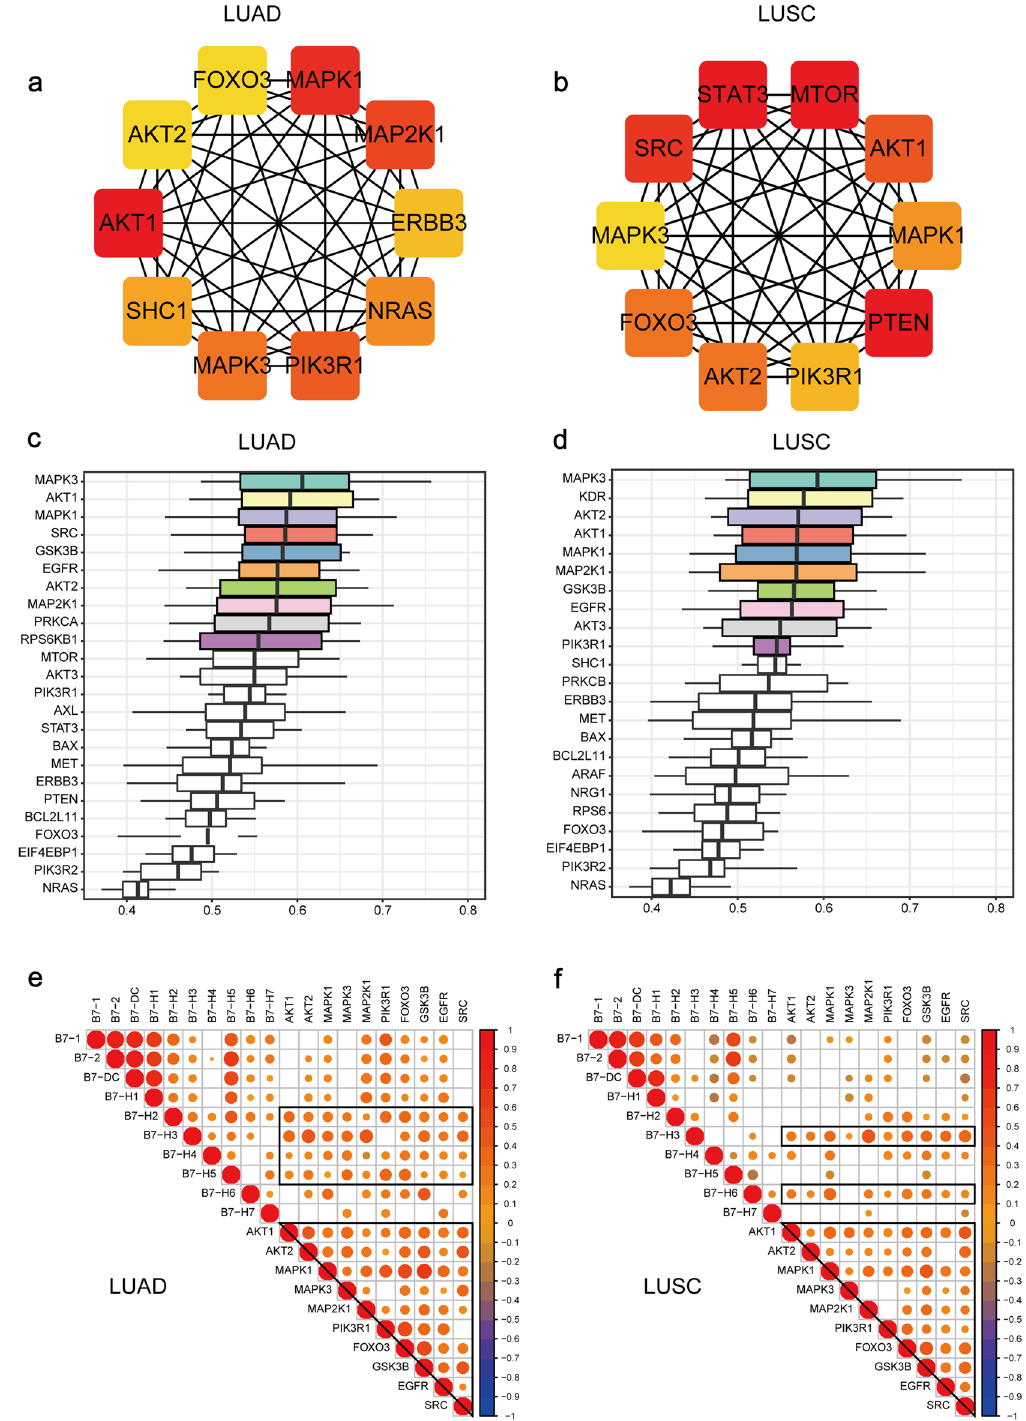
Figure 5. Identification of pivotal B7 family related genes in NSCLC. ( a , b ) Cytoscape identified top10 important differentially expressed proteins regulated by B7 family in both LUAD and LUSC.The intensity of color showed the importance of genes in the networks. ( c , d ) Similarity of differentially expressed proteins based on Gene ontology in different GO terms inLUAD and LUSC. ( e , f ) Correlation analysis of differentially expressed protein-coding genes enriched in the PI3K-Akt signaling pathway and MAPK signaling pathway in LUAD and LUSC. Here, Pearson correlation coefficient was used to quantify the